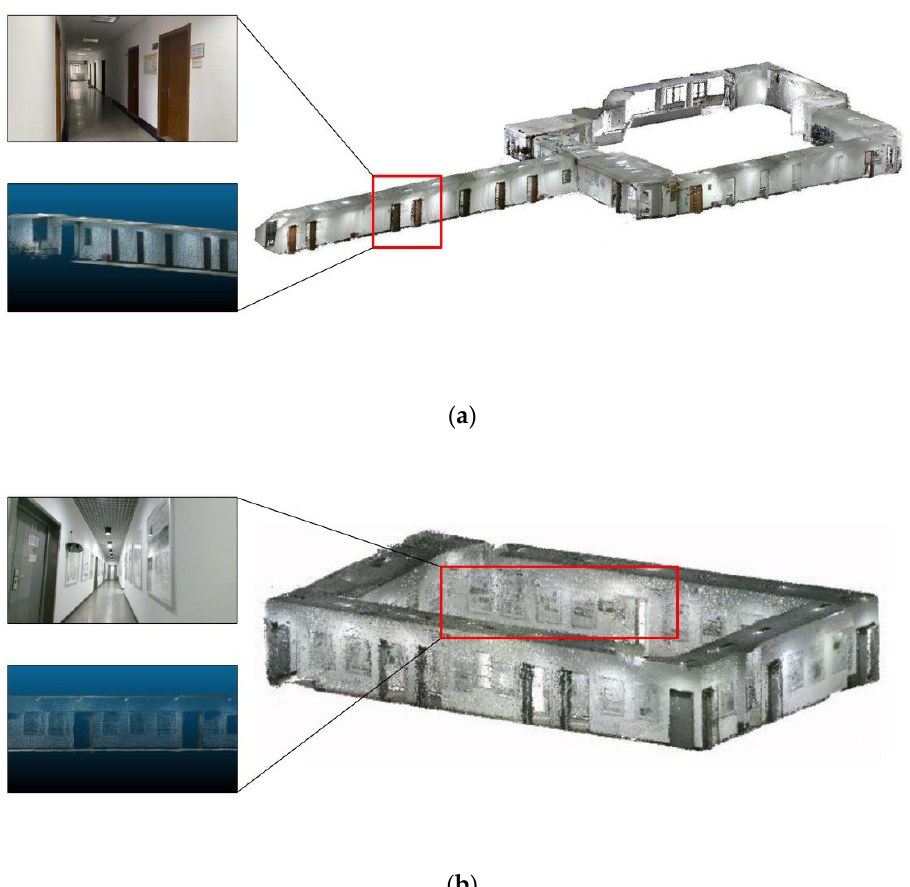
Figure 10. Prior maps obtained after reconstruction: ( a ) the unclosed loop corridor where experi- ment 1 was conducted; ( b ) the loop corridor where experiment 2 was conducted.